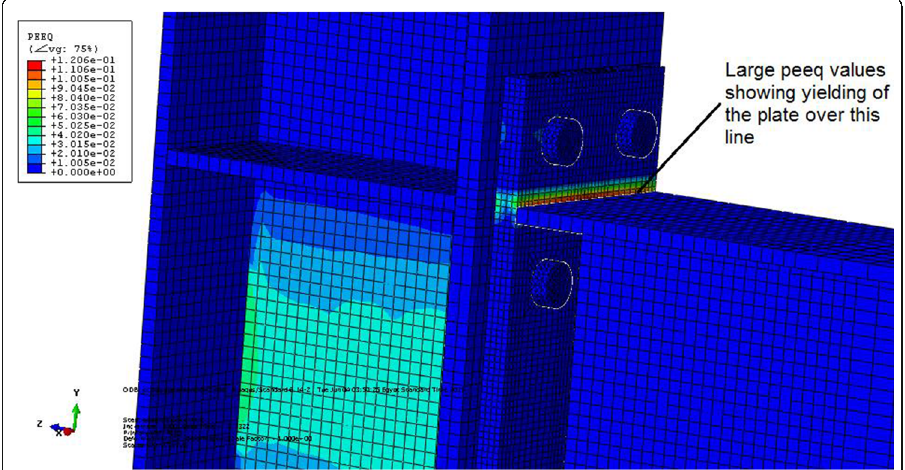
Fig. 17 Strain distribution for connection SC3 at